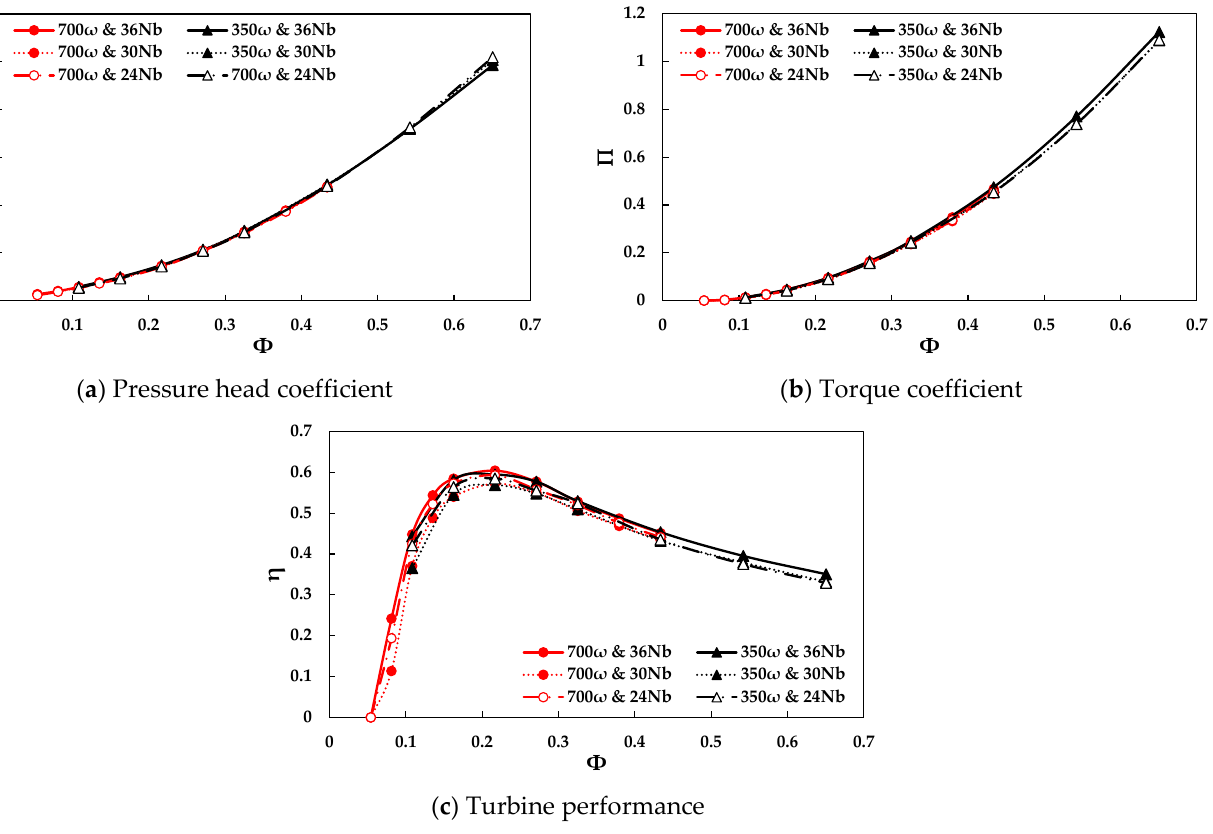
Figure 6. Effect of rotational speed and number of rotor blades on the turbine performance with 3 mm blade thickness.